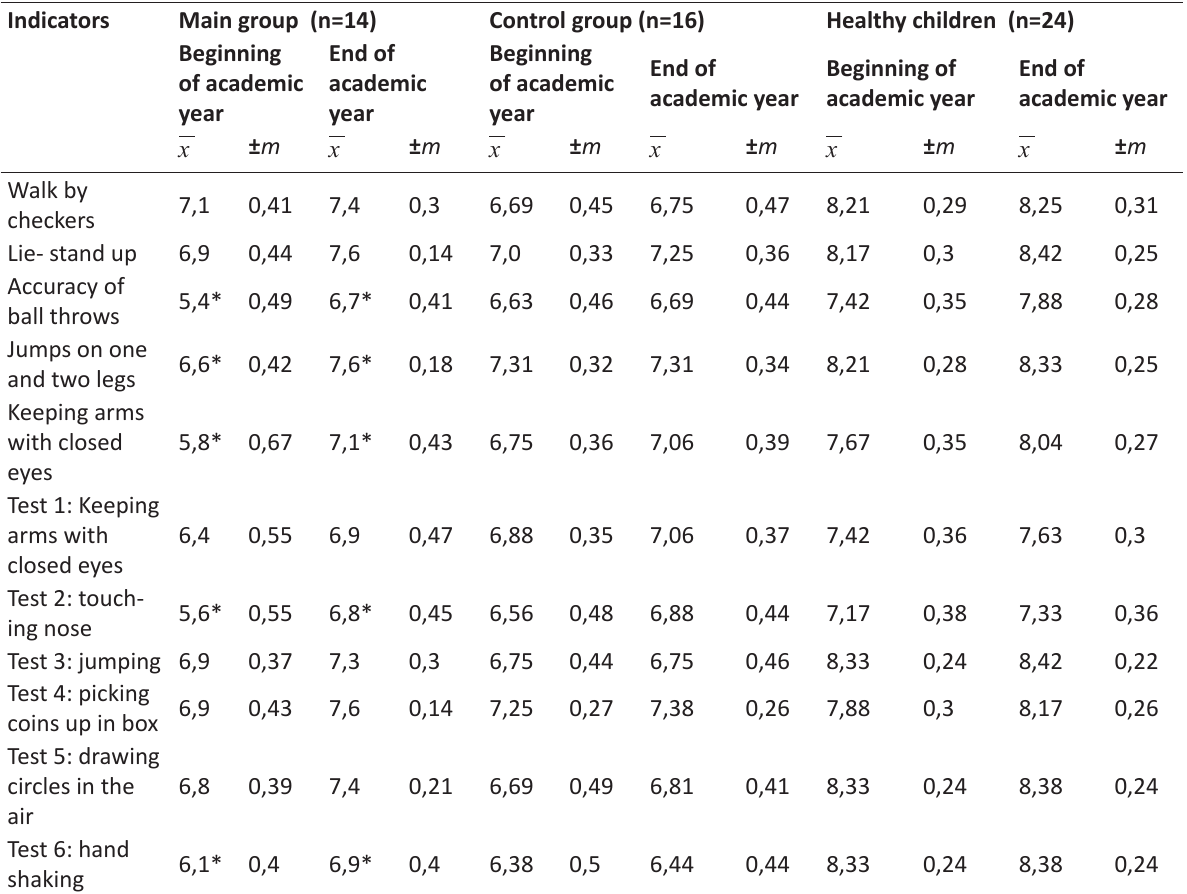
Table 3. Psycho-motor progress of 5-6 yrs healthy children and children with speech disorders Indicators Beginning